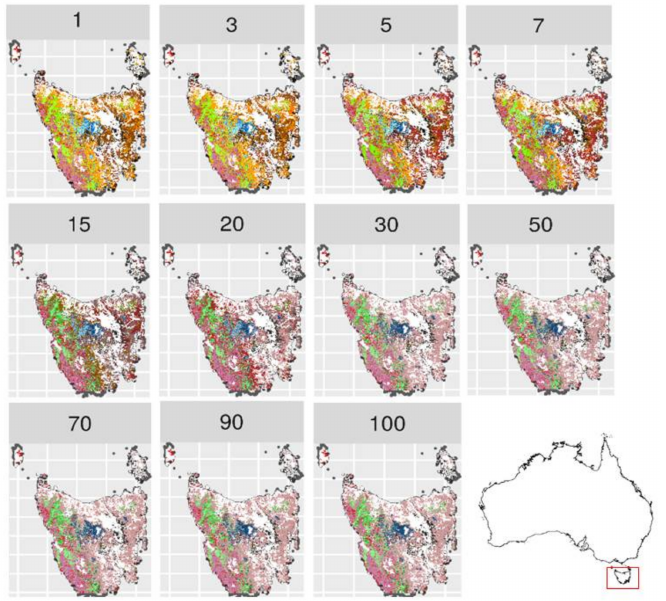
Figure 4. Impact of infrequent fire (every 35 years) on vegetation type across Tasmania. The numbers above each map refer to the number of years from 2000. Colors represent different vegetation types, as follows: Light blues, Subalpine vegetation; Dark blue, Alpine vegetation; Purple, Buttongrass; Oranges, Wet sclerophyll; Dark Orange to Brown, Dry sclerophyll; Greys, Woodland; Reds, Non-eucalypt wet forests; Dark Purple, Non-eucalypt dry forests, Light to Dark Greens,